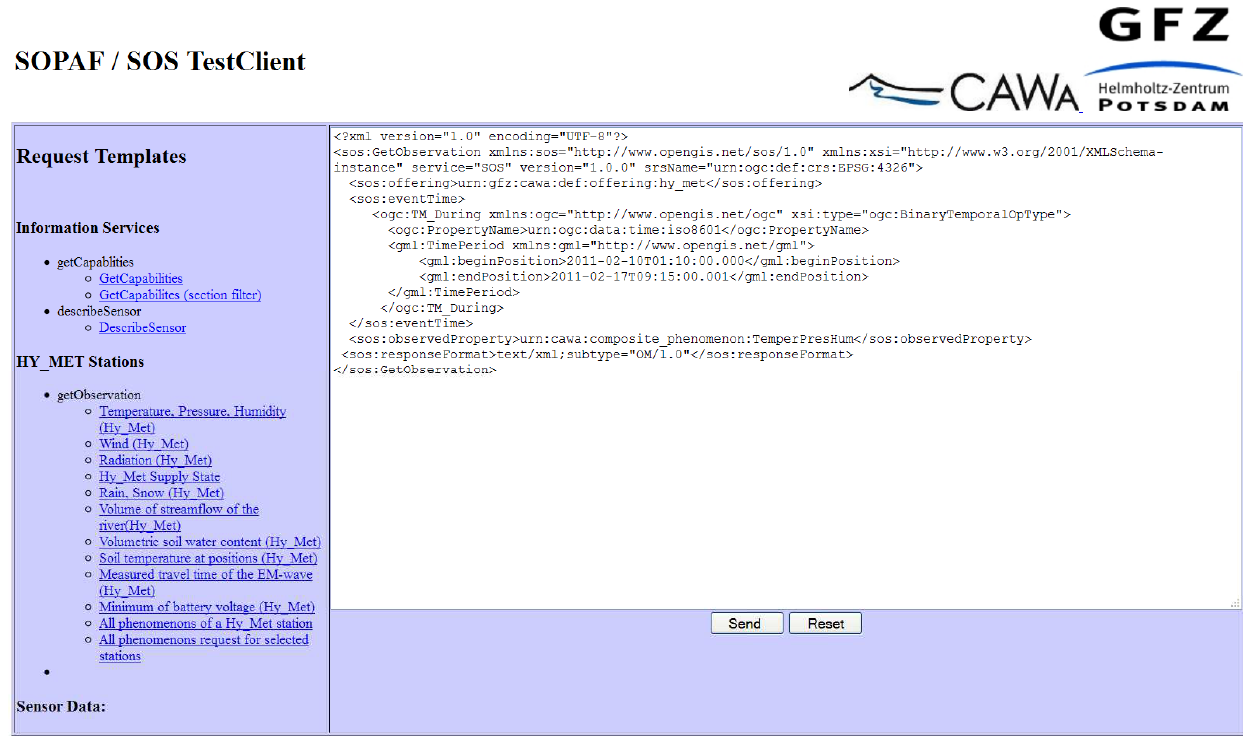
Fig. 5. The SOS Test client, which is designed for writing queries in XML format, contains sample code to support user applications.